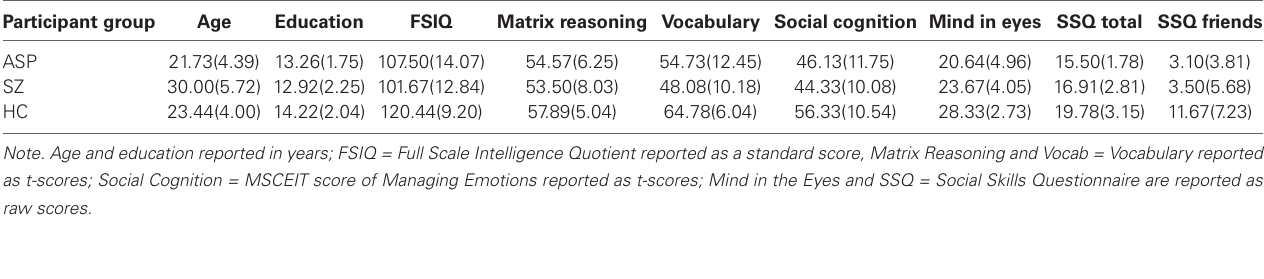
Table 1 | Participant demographics, cognitive scores, and social scores . Participant